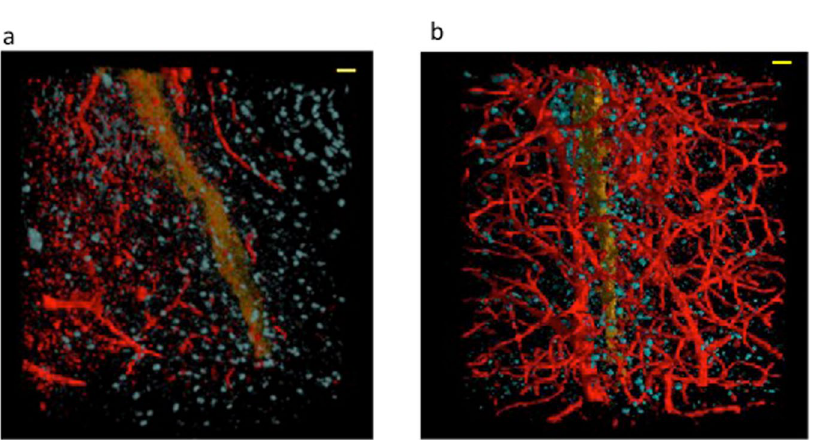
Figure 5. 3D-rendering of the capillary network in spinal cord of EAE-affected mice treated or not with MSC. Longitudinal 3D reconstruction of the capillary network (rendered in red) and cell population (rendered in blue) in spinal cord of untreated ( a ) and MSC-treated ( b ) EAE-affected mice. The spinal canal is rendered in orange. Samples were obtained at 5 dpo. Scale bar: 8 μ m. The pixel size of the nano-XPCT is 130 nm (spatial resolution ~260